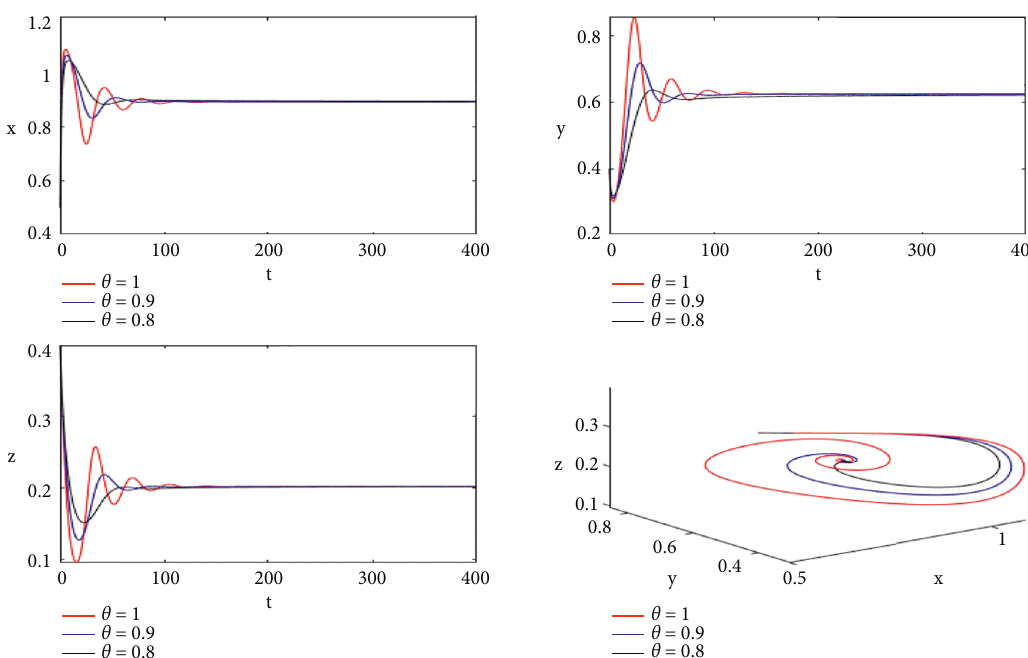
Figure 1: Case 1: the trajectories and phase diagrams of system (92) over time at τ